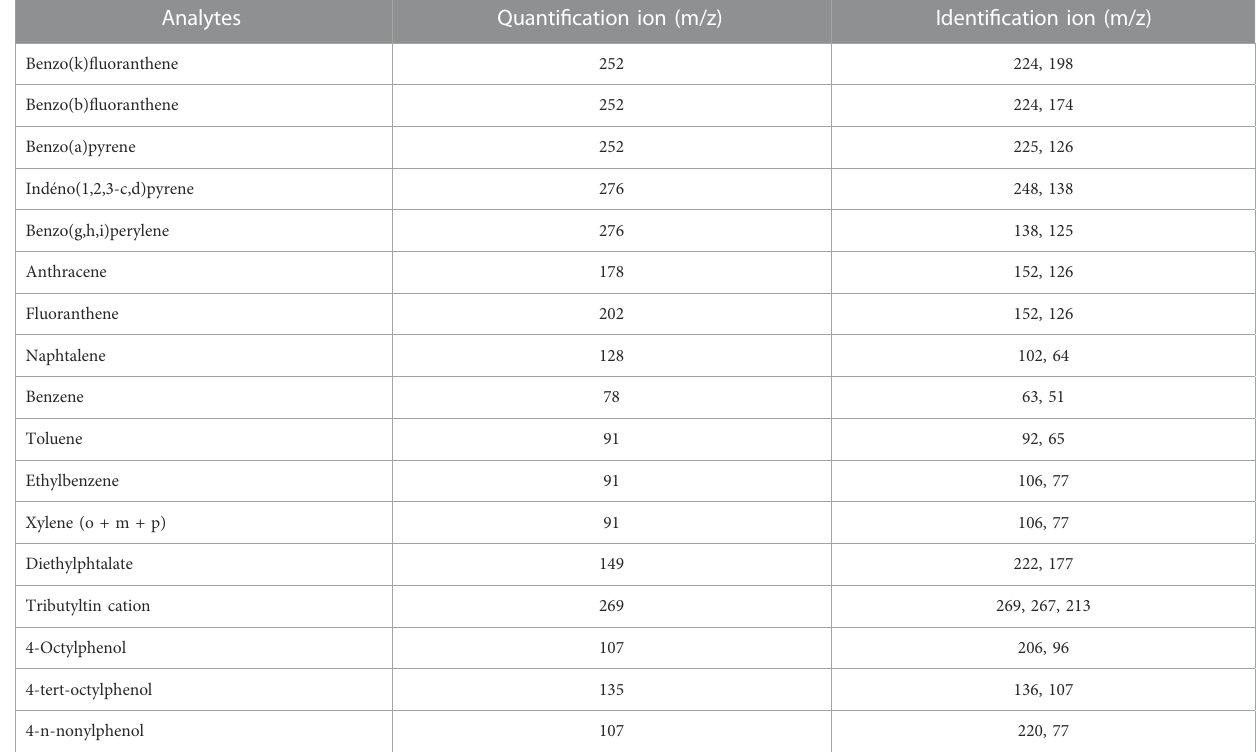
TABLE 2 Physico-chemical characteristics of the sampled soils and GPS localization. Perc.